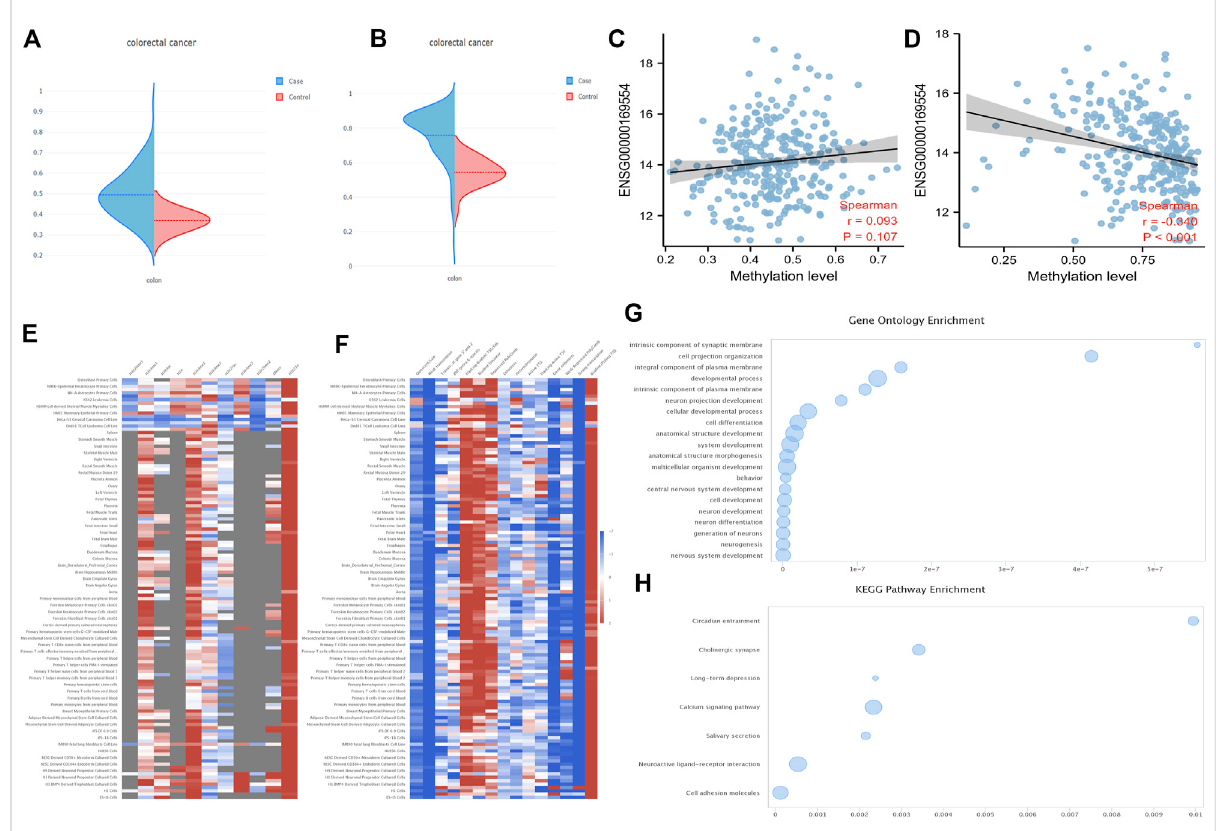
FIGURE 5 The DNA methylation levels of ZEB2. (A) The DNA methylation level of the ZEB2 body. (B) Methylation level of the ZEB2 promoter on the EWAS website. (C) The correlation between DNA methylation of the body and ZEB2 expression. (D) The correlation between DNA methylation of the promoter and ZEB2 expression. (E) The different methylation forms and the enrichment of various histones in different tissues and cells. (F) The chromatin state enrichment results of the ZEB2 methylation probe. (G,H) The GO/KEGG enrichment analysis of ZEB2 methylation